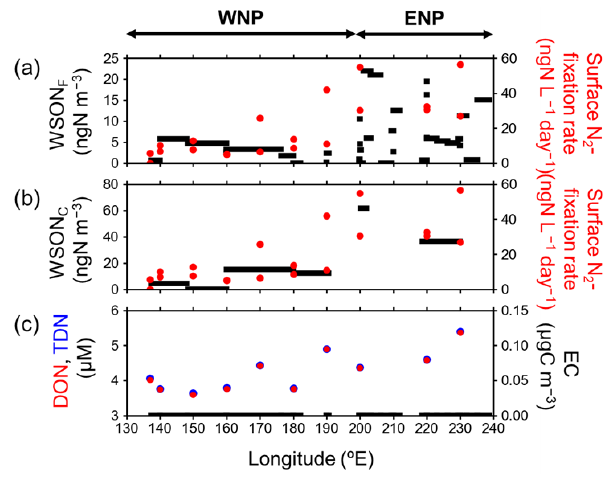
Figure 5. Longitudinal distributions of mass concentrations of (a) WSON F (black) and (b) WSON C (black), together with N 2 -fixation rate in the SSW samples (red solid circle), and (c) DON (red solid circle) and TDN (blue solid circle) concentrations in surface seawa- ter and aerosol EC concentrations (black) during the entire cruise.